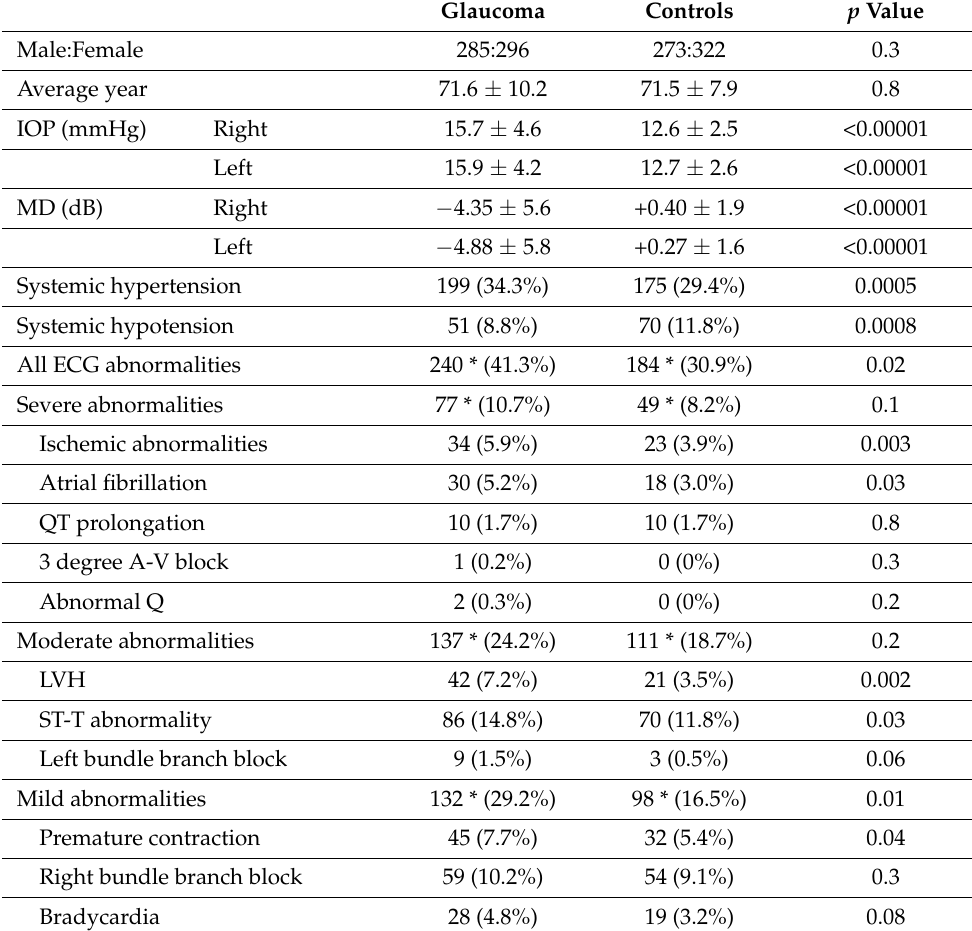
Table 1. Demographic data of the patients with glaucoma and the